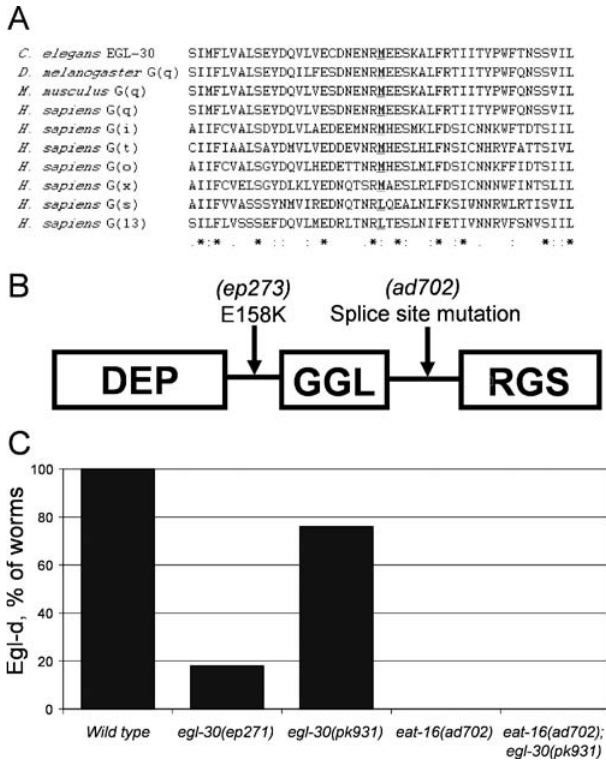
Figure 4. Protein Mutants Identified and Epistasis Tests (A) Alignment of a region of EGL-30 containing the M244I amino acid substitution with other G-proteins. The conserved methionine residue that is mutated to isoleucine in the egl-30(ep271) allele is indicated in bold text and underlined. (B) Diagram showing the domain structure of the EAT-16 protein with relative locations of the E158K substitution found in the eat-16(ep273) allele, and the splice site mutation found in eat16(ad702) strains. (C) Genetic interactions between mutations in G- a q and RGS. The G- a q/ egl-30(ep271) and RGS /eat-16(ad702) mutations confer resistance to BMS- 192364. The sensitivity of a G- a q/ egl-30(pk931) strain to BMS-192364 is abrogated in the presence of the eat-16(ad702) mutation. DOI: